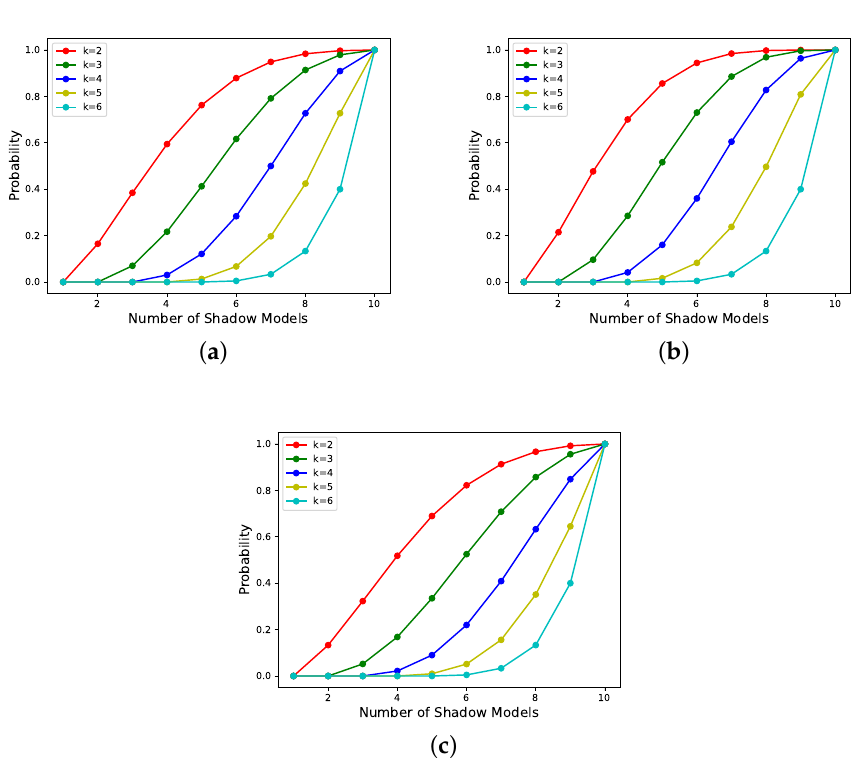
Figure 3. When n is constant, the relationship between x and P ( j (cid:62) k ) for different determined sharing states. ( a ) All candidate shadow models’ weights and shadow models’ weights are 1. ( b ) 3 of candidate shadow models’ weights are 10, and the rest are 1. 3 of shadow models’ weights are 10, and the rest are 1. ( c ) 3 of candidate shadow models’ weights are 1, and the rest are 10. 3 of shadow models’ weights are 1, and the rest are